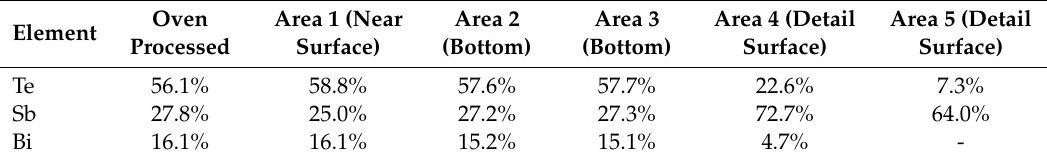
Table 5. Mass fraction in % of the elements of p-type material after oven processing and in several areas of a laser processed specimen ( E sq. = 0.154 J / mm 2 ).